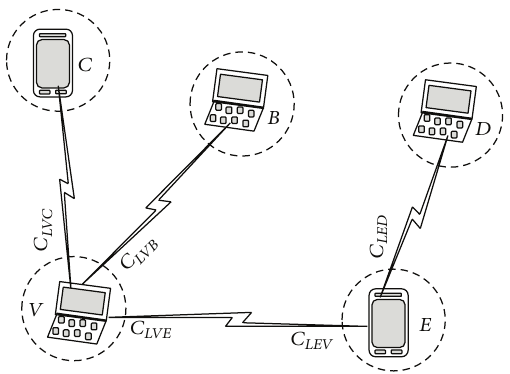
Figure 2: Weight determination for each